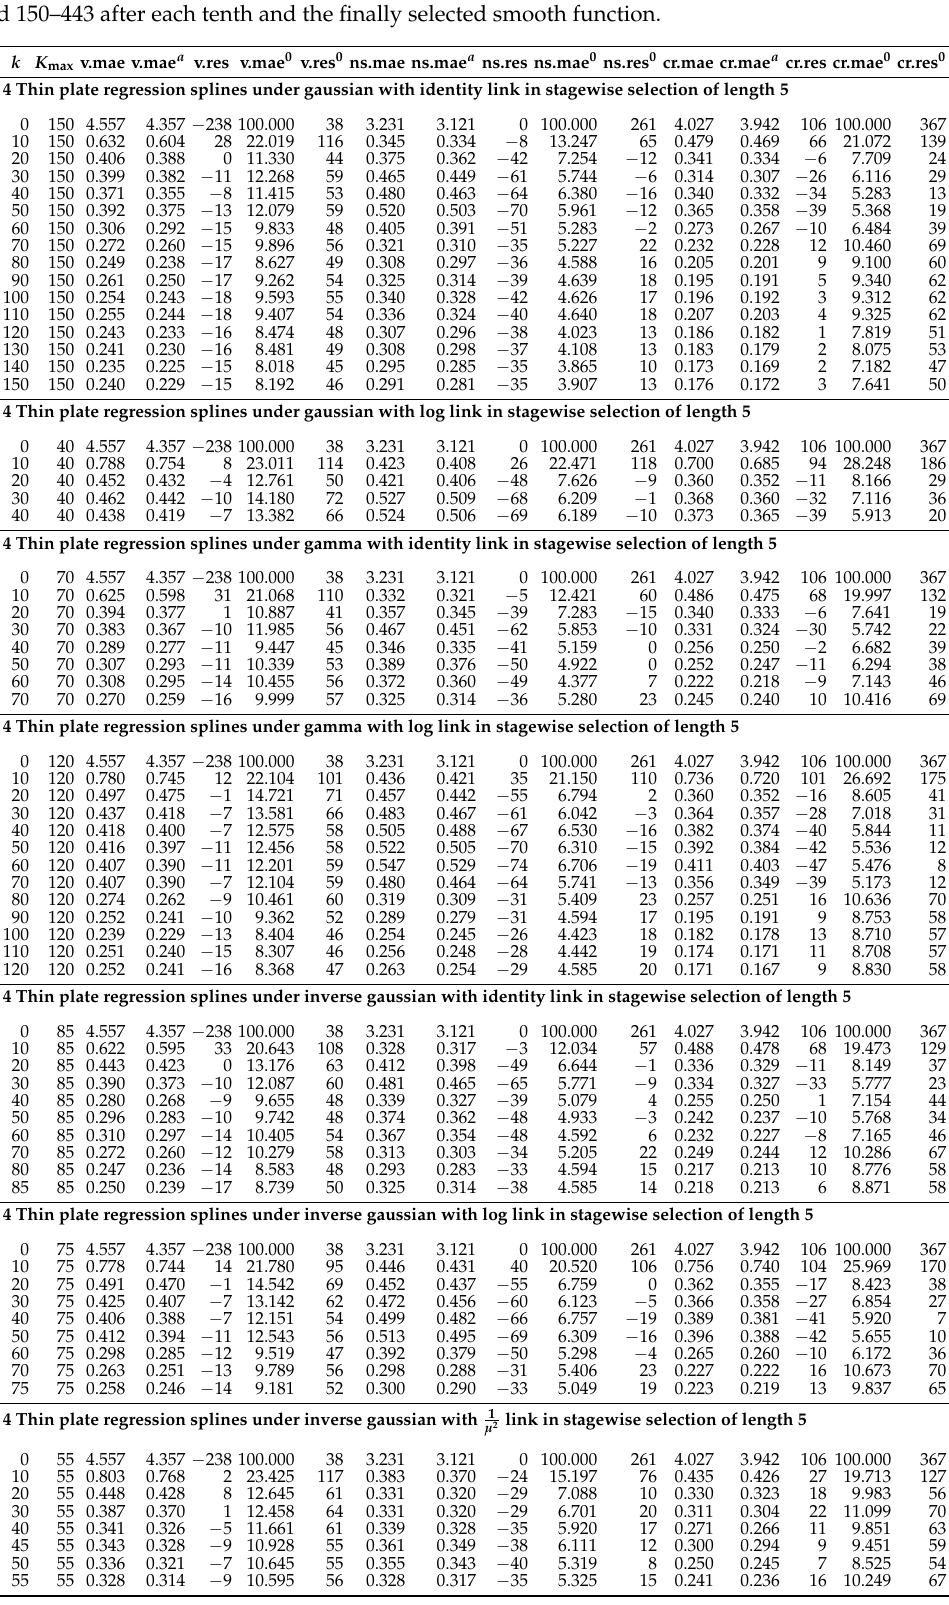
Table A19. Out-of-sample validation figures of selected GAMs of BEL with varying random component link function combination and fixed spline function number of 4 per dimension under between 40–443 and 150–443 after each tenth and the finally selected smooth